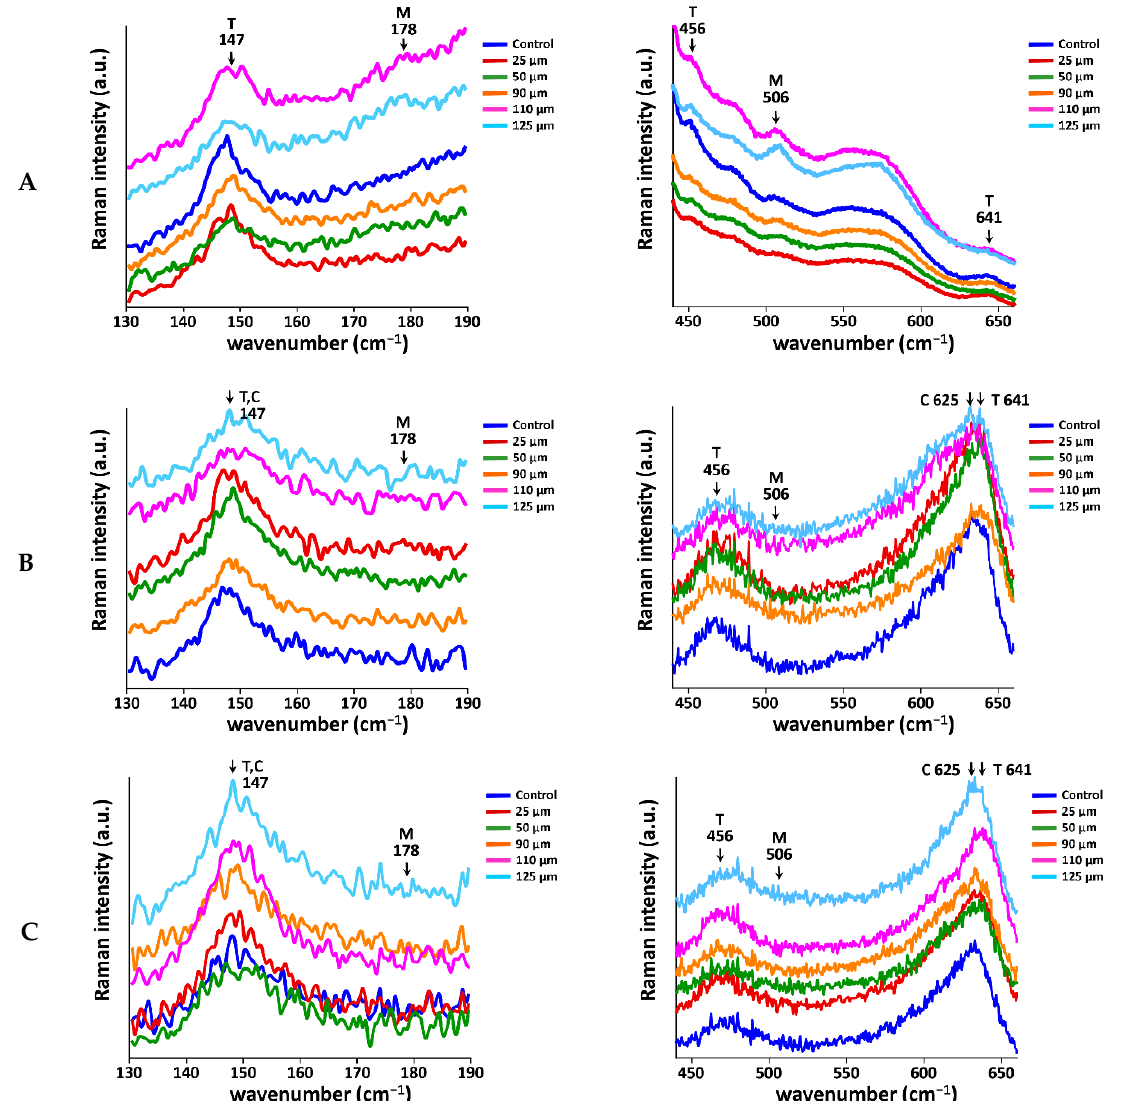
Figure 6. Representative µ Raman spectra for each subgroup of three zirconia grades. ( A ) 3Y-TZP.; ( B ) 4Y-PSZ.; ( C ) 5Y-PSZ. The shapes of the spectra for 3Y-TZP specimens are clearly different from those for 4Y- or 5Y-PSZ specimens. In order to confirm the crystalline structures of the specimens, Raman peaks from 130 to 190 cm −1 and from 440 to 660 cm −1 are shown. For 3Y-TZP, the tetragonal peaks at 147, 456, and 641 cm −1 decreased, while the monoclinic peaks at 178 and 506 cm −1 increased as the particle size increased. For 4Y- and 5Y-PSZ, the tetragonal peaks at 641 cm −1 decreased, whereas the cubic peaks at 625 cm −1 were maintained.